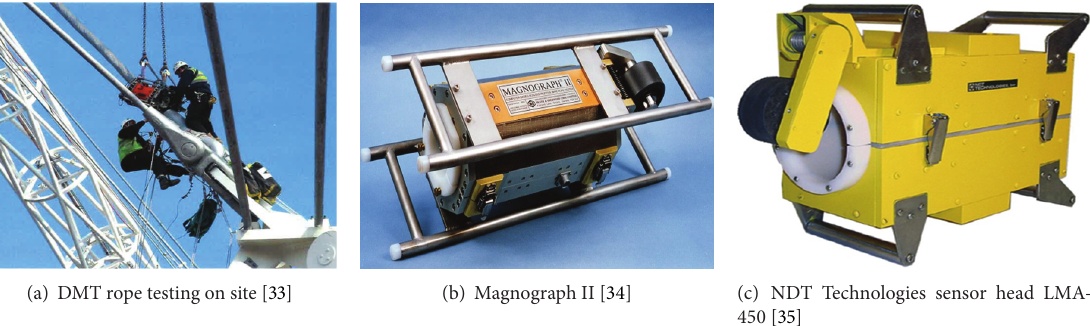
Figure 8: Commercially available magnetic sensor for bridge cable inspection.